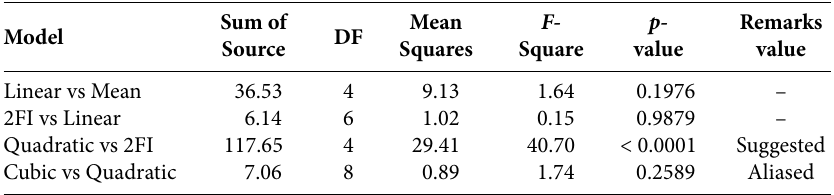
Table 3. Experimental curve fitting of